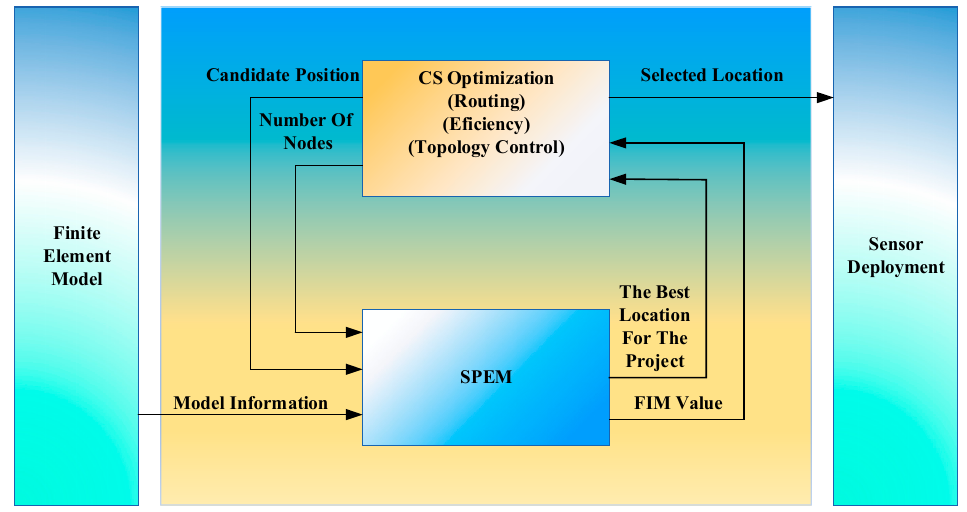
Figure 4. Sensor placement using EFI method.